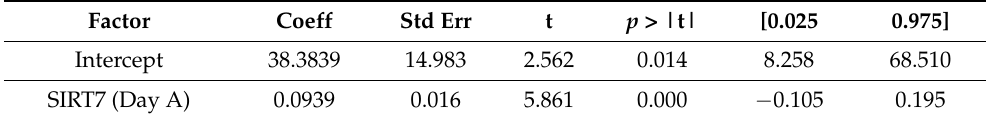
Table 5. Results of a simple linear regression testing the relationship between expression of SIRT7 on day A and the CD34+ peak value in peripheral blood on the day of first apheresis.